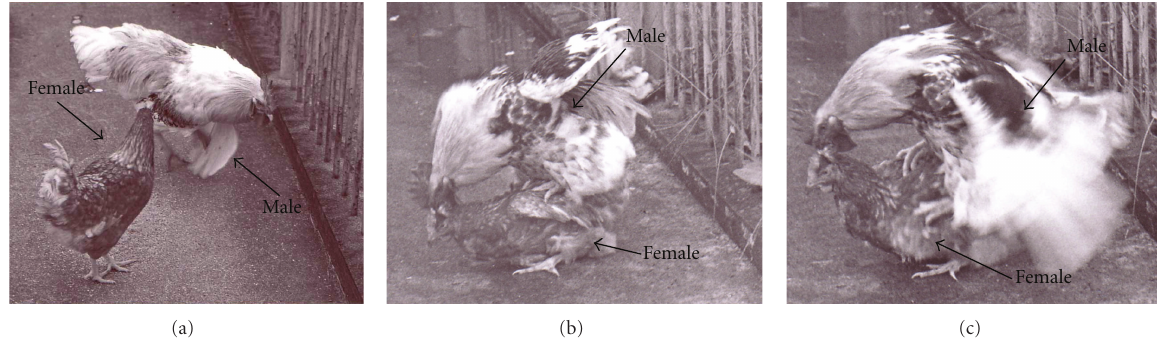
Figure 1: Photographs of sexual behavior exhibited by domestic chickens. (a) Courtship waltzing, (b) mounting, and (c) copulation.